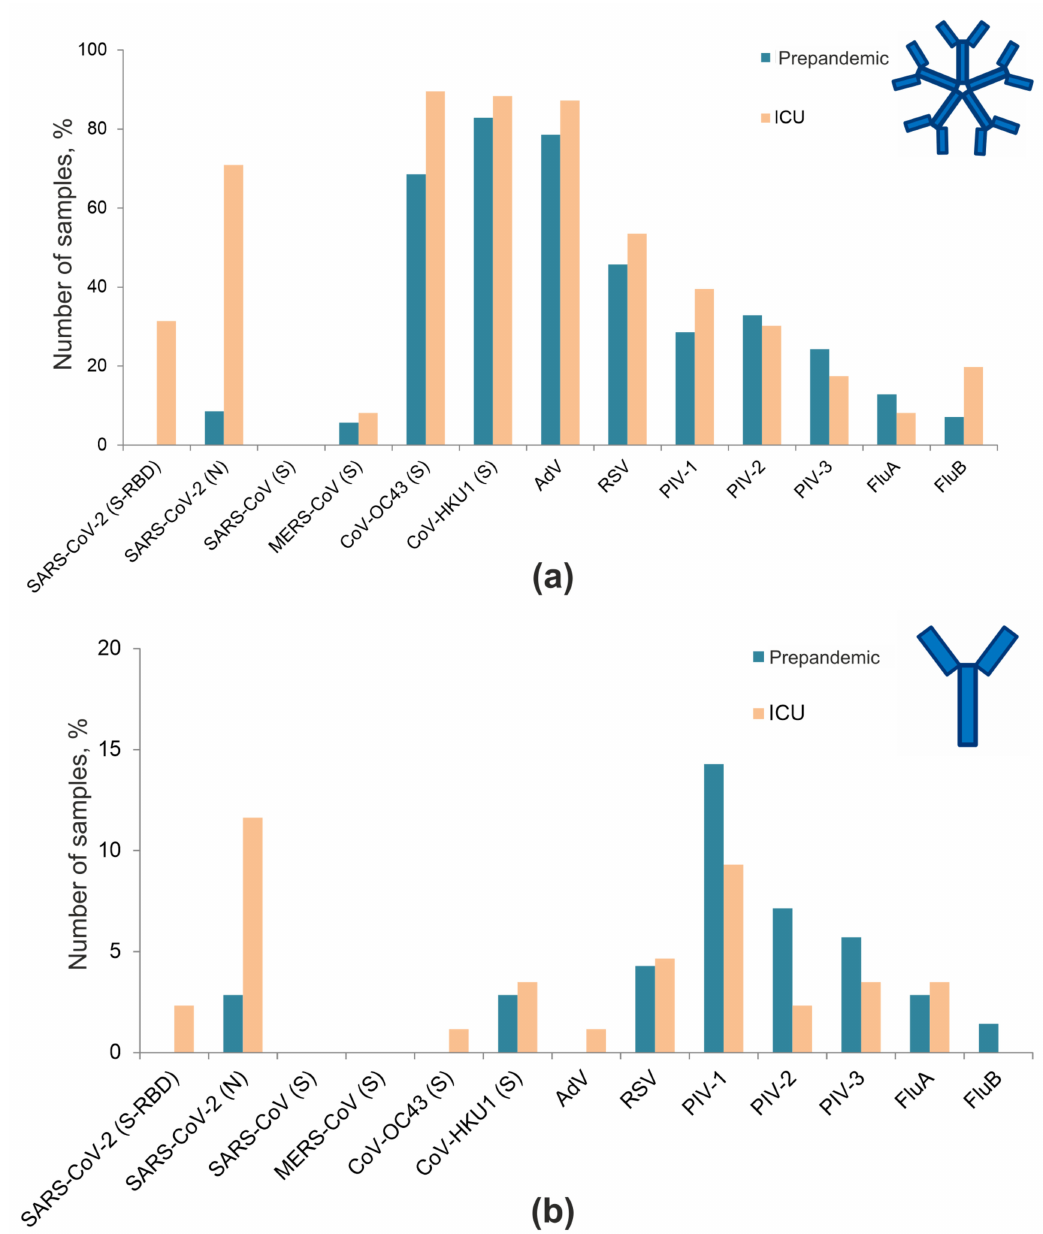
Figure 6. Frequencies of IgM ( a ) and IgG ( b ) antibodies against respiratory viruses in the prepandemic cohort and COVID-19 ICU